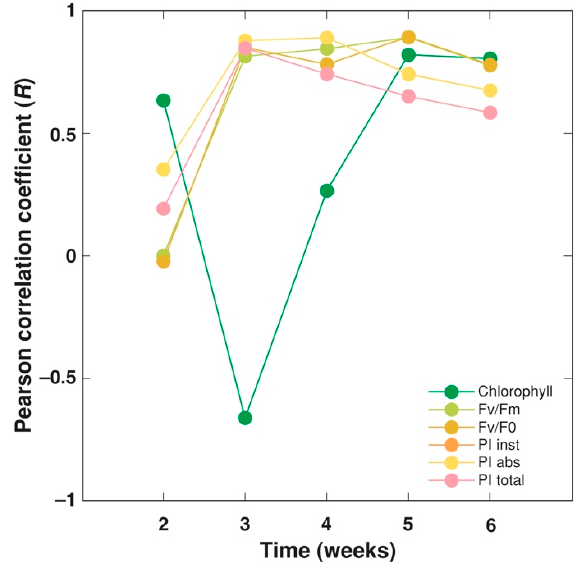
Figure 14. Changes of average correlation between physiological indices and yield parameters (fresh and dry mass of leaves and stems) of Dracocephalum moldavica plants during cultivation in peat substrate and commercial garden soil with different amendments. PI inst has the same values as PI abs and cannot be seen.